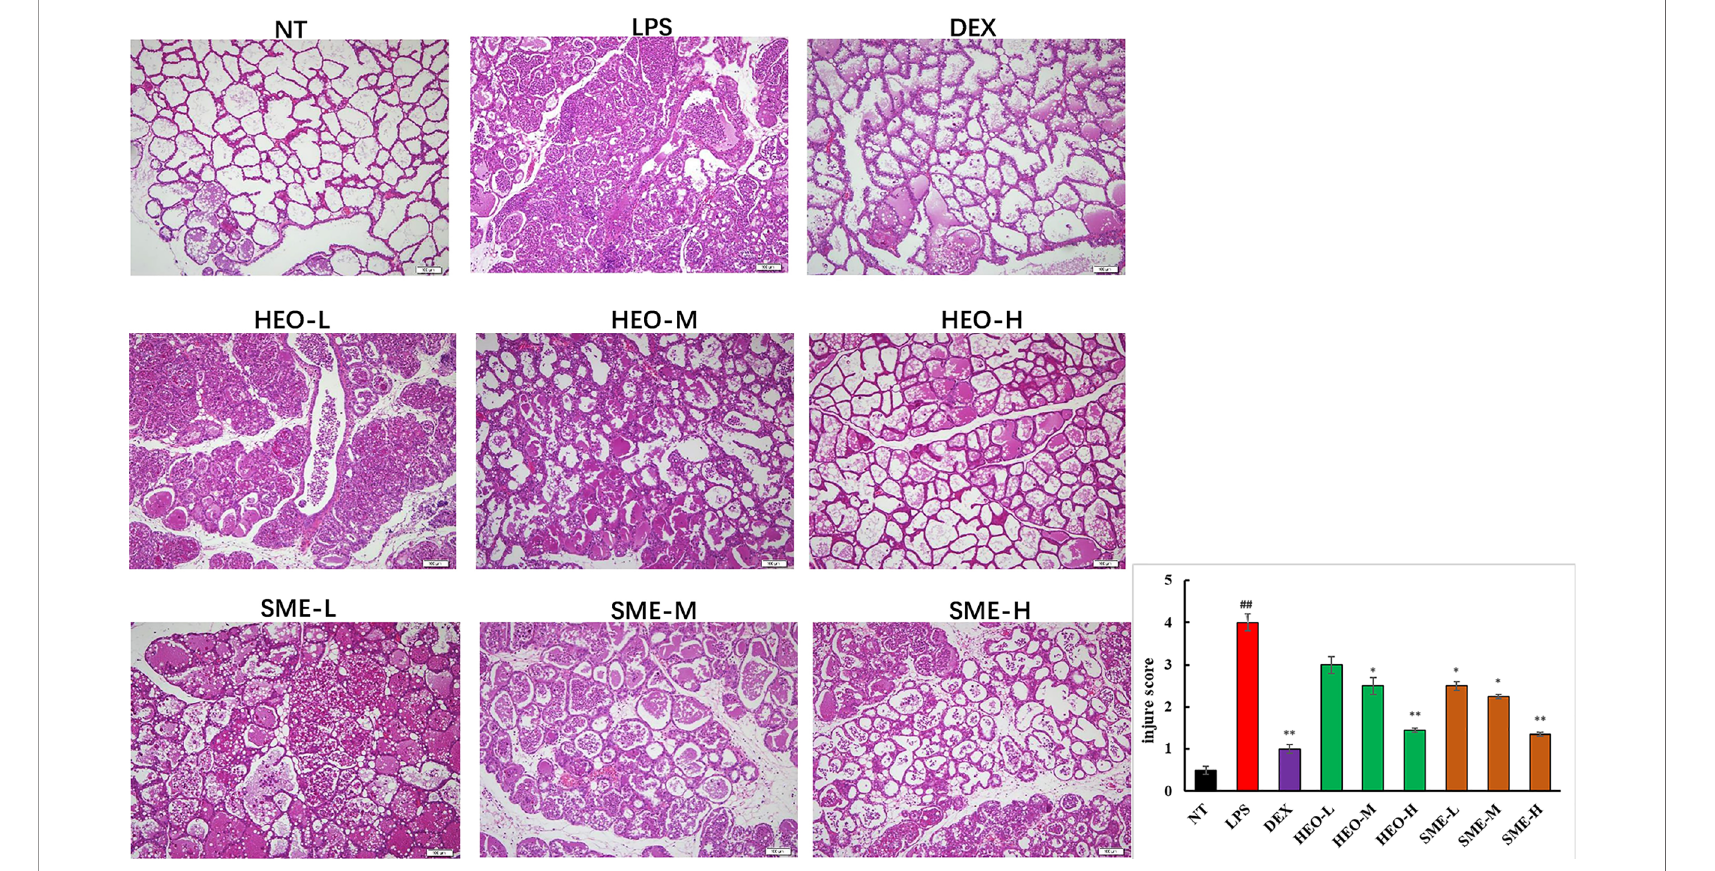
FIGURE 3 | Representative images of pathological injury to mammary gland tissue in LPS-induced murine mastitis. Mammary gland tissues from each experimental group (n = 6) were obtained 24 h after LPS administration, sectioned, and stained with H&E (magni fi cation ×100). ( ## P < 0.01 compared to NT group, * P < 0.05, ** P < 0.01 compared to model